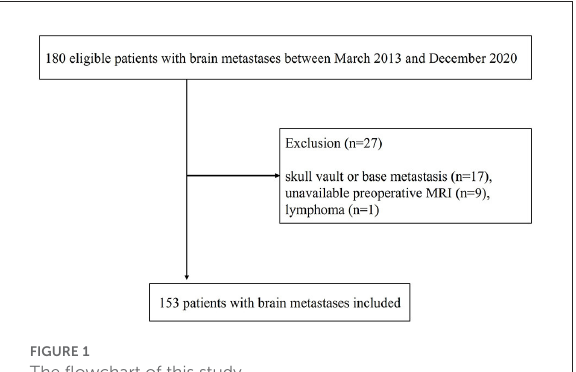
FIGURE1 The flowchart of this